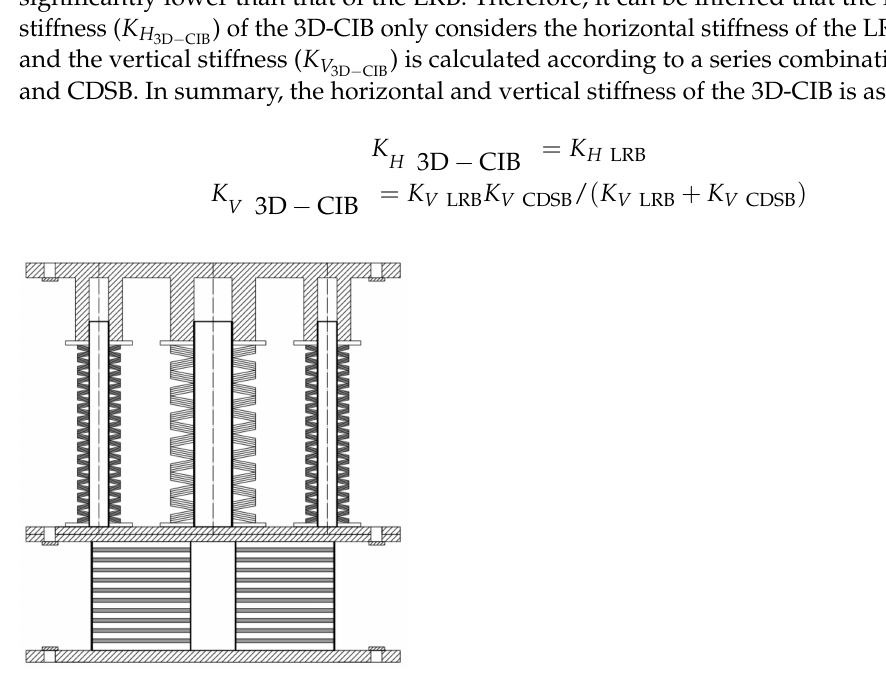
Figure 3. Section view of the 3D combined isolation bearing